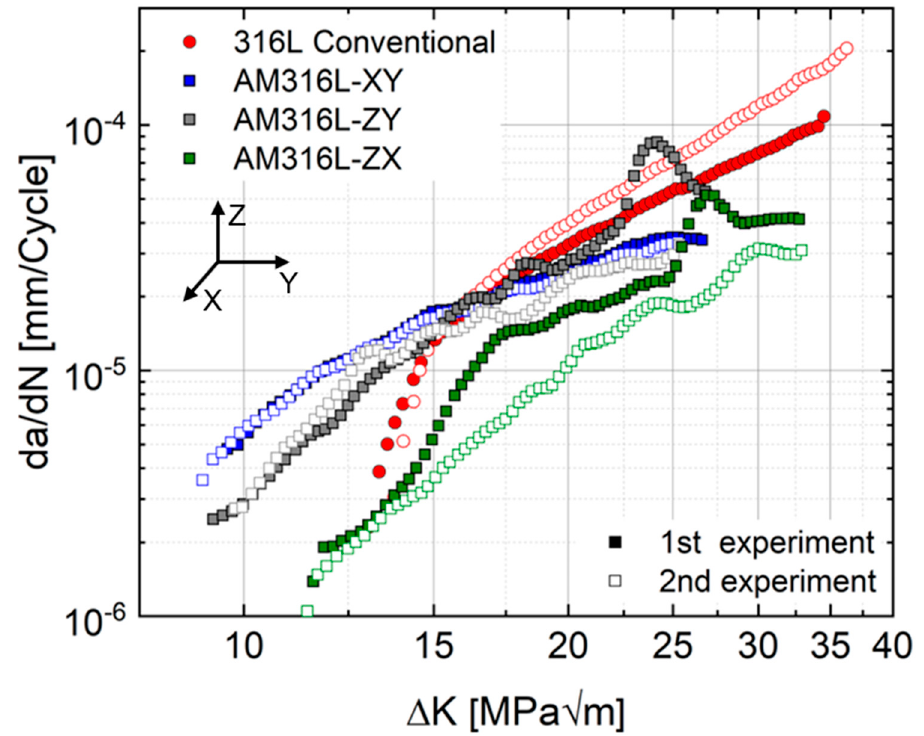
Figure 7. Crack growth in LPBF (three di ff erent build directions) and conventionally manufactured 316L at ambient temperature.